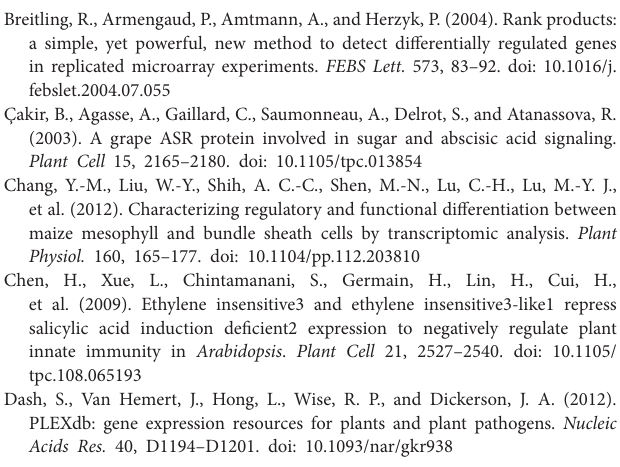
Supplementary Figure S1 | Venn diagram of specific and common significantly enriched biological processes terms in maize ( Zea mays ) and rice ( Oryza sativa